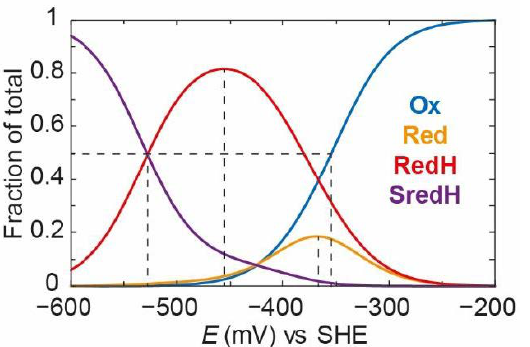
Figure 13. Variation of the fraction (out of 1) of the deprotonated oxidised ( Ox , blue), deproto- nated reduced ( Red , orange), protonated reduced ( RedH , red), and protonated super-reduced ( Sred H, purple) species as a function of the applied potential at pH 7. The curves were obtained using = − 100 mV, Equation (35) ( α n values defined in SI Section S3), with E O = − 370 mV, E O = − 700 mV, E O 2 3 1 and E O = − 430 mV giving an average E O of − 400 mV, for a comparison with earlier figures, 4 redox anti-cooperativity of 100 mV resulting in E O = − 470 mV, E O = − 700 mV, E O = − 100 mV, 5 6 7 and E O = − 530 mV, E O = − 370 mV, K a, 1 = 3.16 × 10 − 3 ( pK a, 1 = 2.5), and K a, 4 = 3.16 × 10 − 3 8 9 ( pK a, 4 = 2.5). The calculated parameters (using Equations (36)–(44)) were then: E O = − 470 mV, 10 E O = − 470 mV, E O = − 370 mV, E O = − 370 mV, and E O = − 470 mV, K a, 2 = 8.58 × 10 − 8 ( pK a, 2 = 7.1), 11 12 13 14 K a, 3 = 2.33 × 10 − 12 ( pK a, 3 = 11.6), K a, 5 = 1.75 × 10 − 9 ( pK a, 5 = 8.6), K a, 6 = 2.33 × 10 − 12 ( pK a, 6 = 11.6). Ox = OxOx + RedOx , Red = OxRed + RedRed , RedH = OxRedH + RedRedH , SredH = OxSredH + RedSredH. OxH and Sred are not shown because their concentrations are effectively